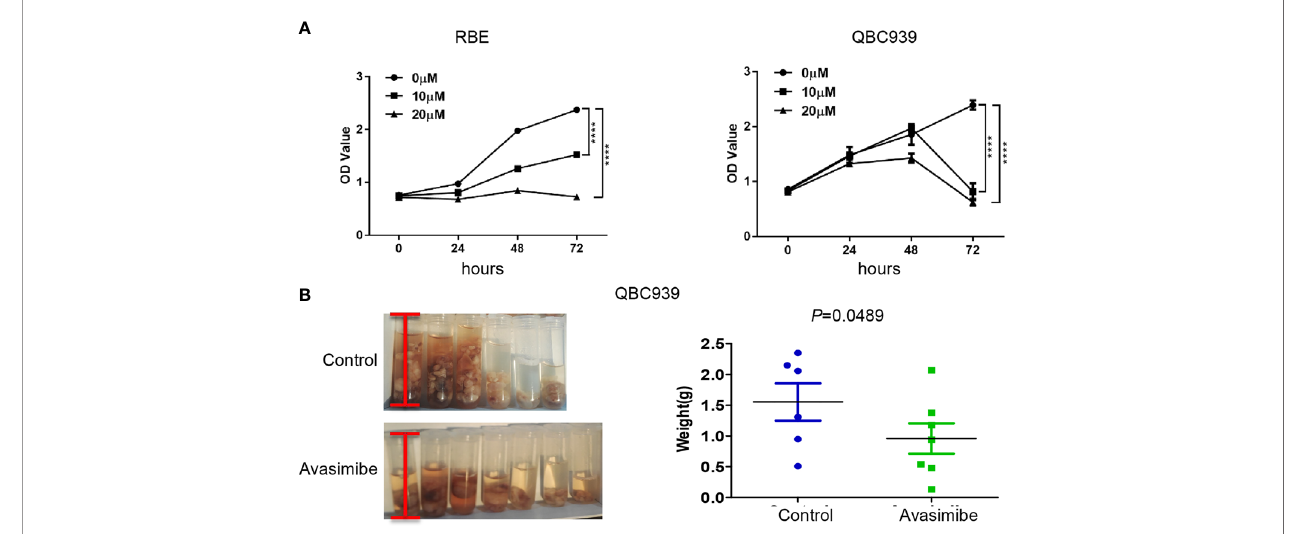
FIGURE 1 | The inhibitory effect of avasimibe treatment on cell proliferation and tumor growth of cholangiocarcinoma. (A) RBE and QBC939 cells were treated with avasimibe at indicated concentrations (0 m M, 10 m M, and 20 m M) and cell proliferation was measured by CCK8 assay at 24h, 48h, and 72h. ****P < 0.0001. (B) QBC939 cells (1×106 per mouse) were injected into the abdominal cavity of 6-week-old female Balb/c nude mice. Mice were given avasimibe (n=7) or regular water (n=6) by oral gavage for 21 days. The tumor volume and tumor weight were examined at 22 days. CCK8, Cell Counting